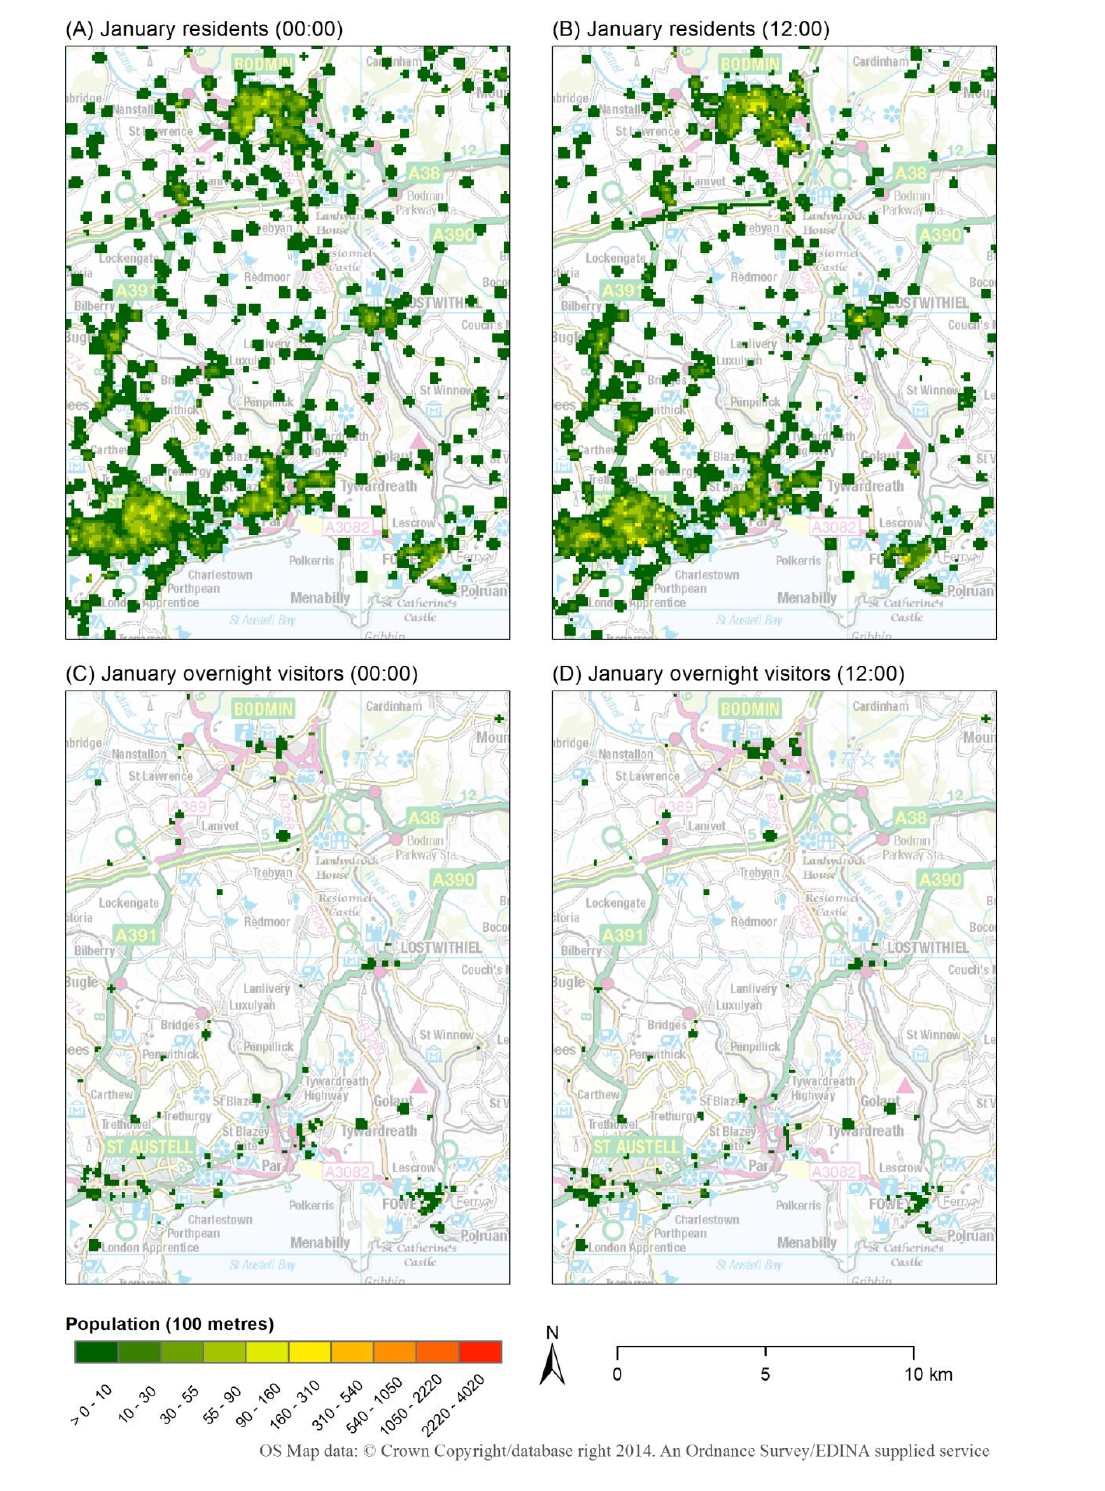
Figure 7. Modelled seasonal population distribution (100 m) for the St Austell study area for a January weekday. ( A ) usually resident night-time (00:00) population, ( B ) usually resident daytime (12:00) population, ( C ) overnight visitor night-time (00:00) population and ( D ) overnight visitor daytime (12:00)